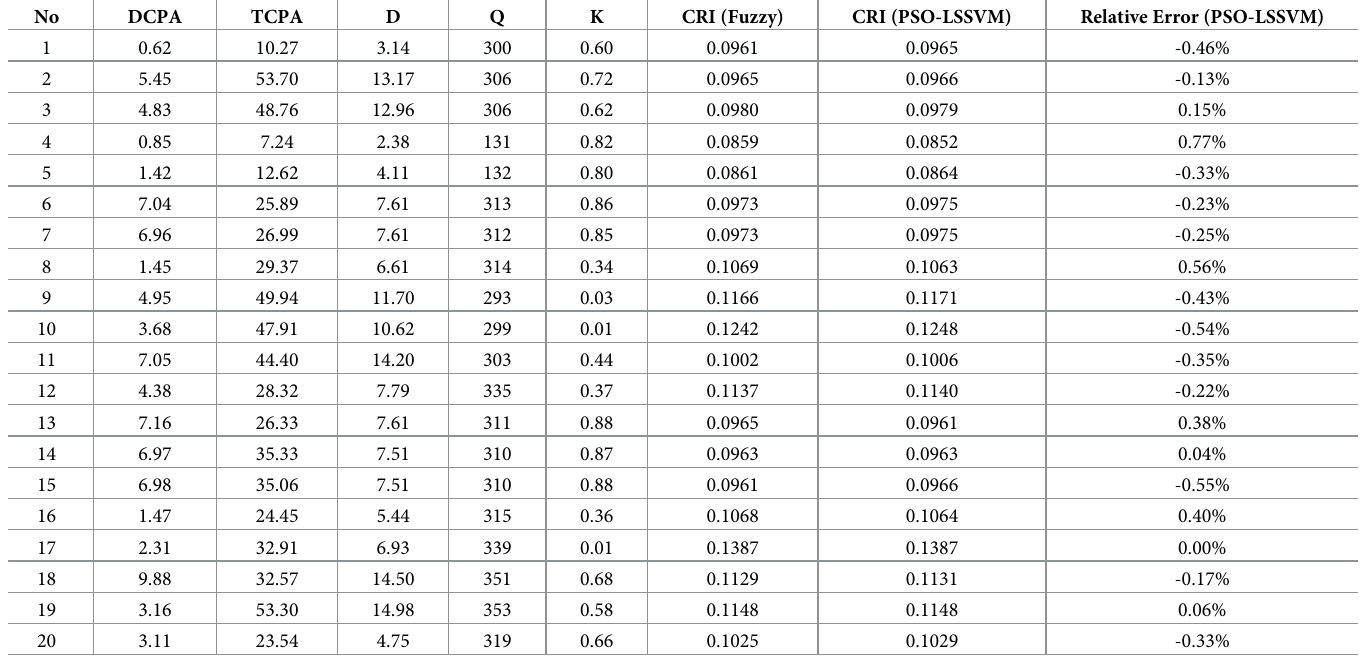
Table 2. Some training samples and results for the CRI-based PSO-LSSVM